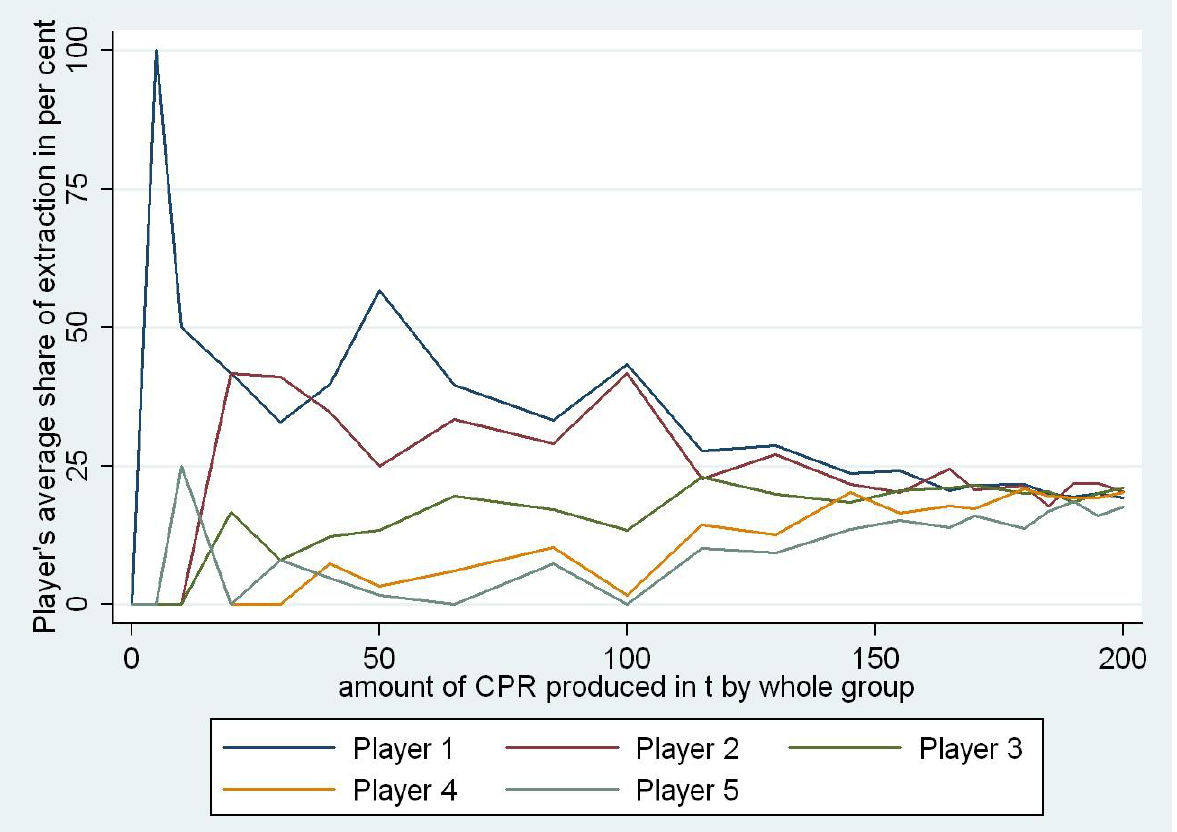
Figure A3.1. Share of extraction for players occupying different positions as a function of the total amount of CPR